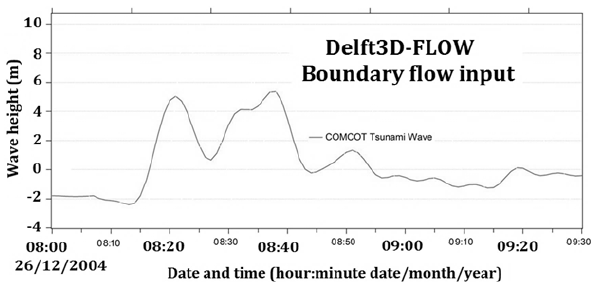
Figure 7. Delft3D-FLOW boundary flow input from COMCOT re-